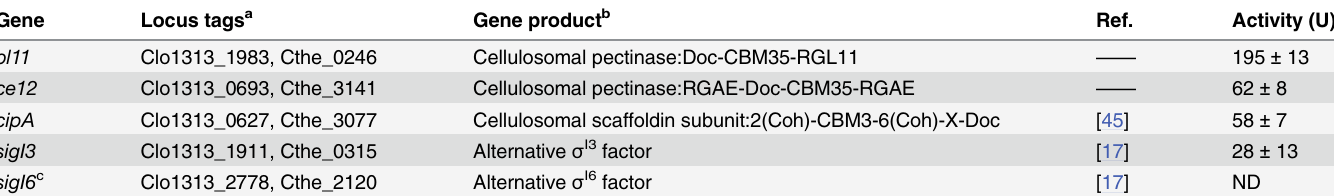
Table 4. Quantitative evaluation of possible promoters under the control of C . thermocellum σ I3 . Gene Locus tags